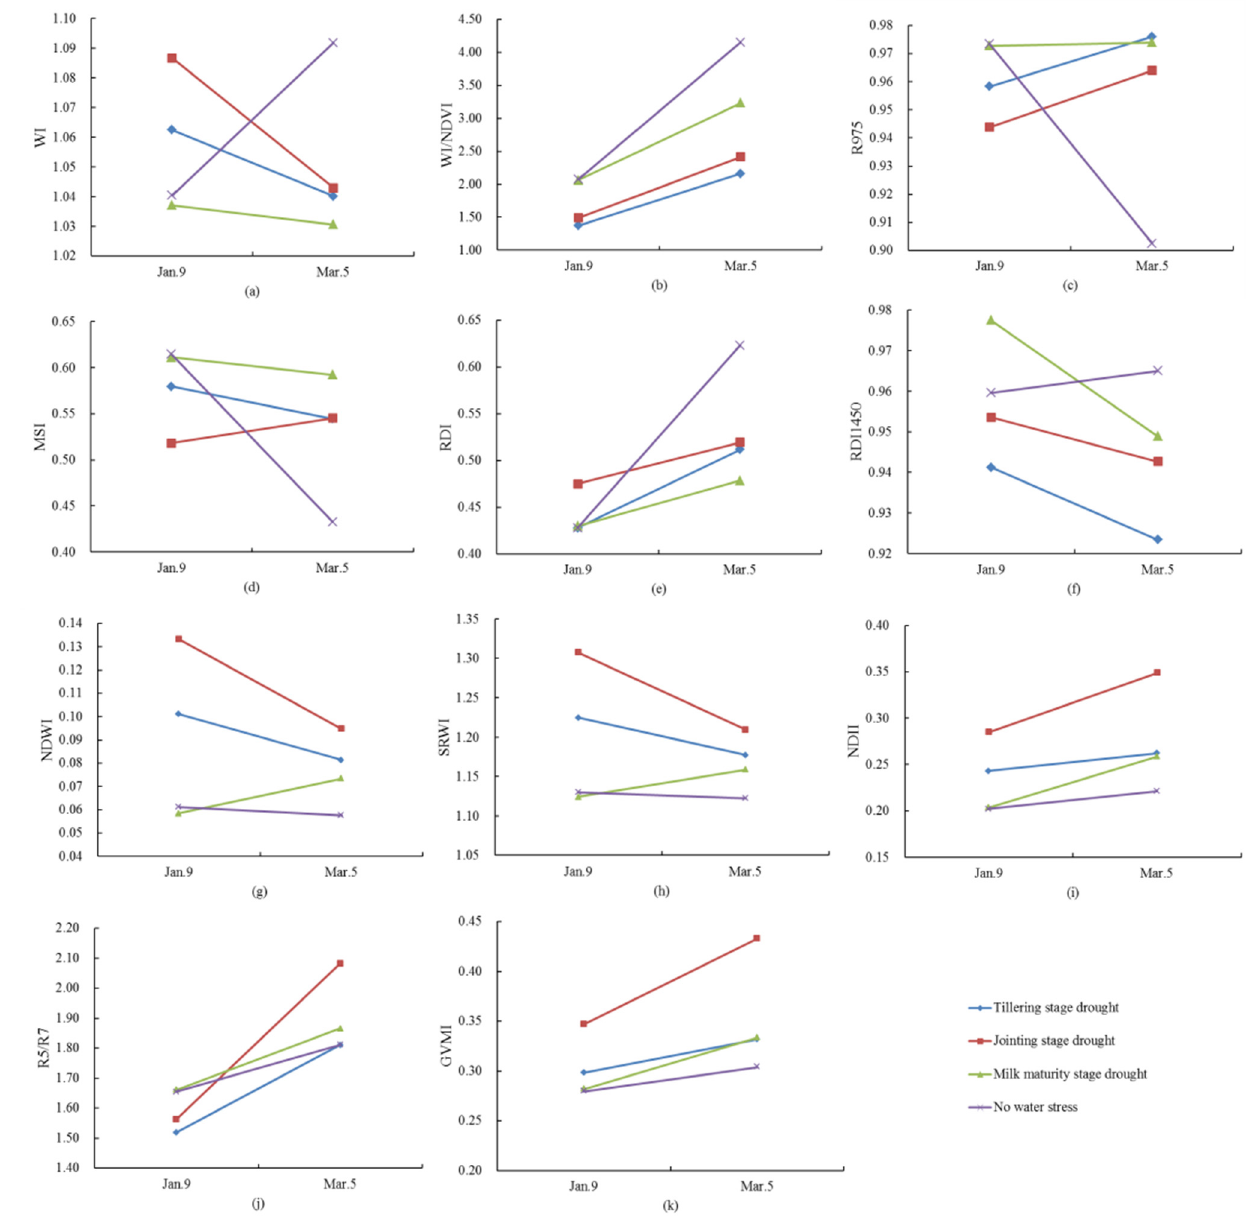
Figure 5. The slope change in eleven VWIs on two observation dates (Jan. 9 and Mar. 5) for different growth stages drought for wheat.